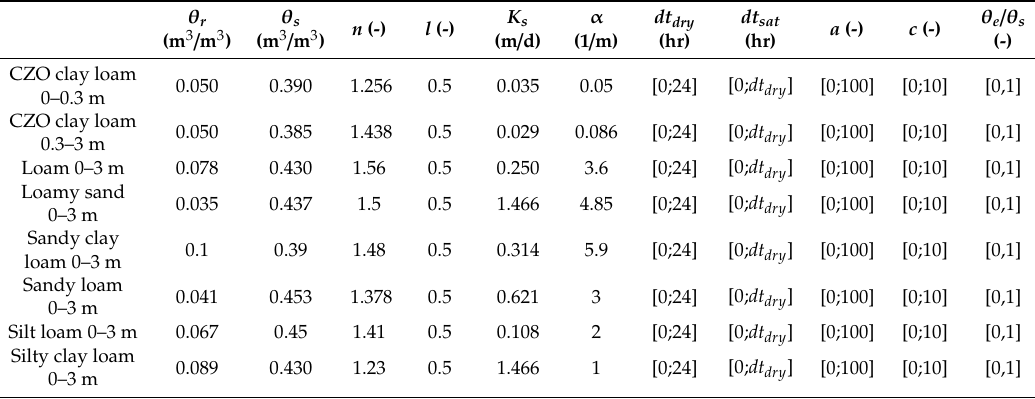
Table 1. Input soil parameter values and the range of the calibration parameters used in the Shallow Subsurface Modelling Framework (SSMF). The procedure to determine the value of the soil parameters is described in the Supplementary Material. For the CZO clay loam profile, the soil parameters θ r , θ s , n , l , K s and α reported in this table were obtained from the calibration of the Richards equation with HYDRUS on soil data from the Sunjia catchment. For the six generic soil texture profiles, they are the literature values provided in HYDRUS by the ROSETTA pedotransfer model [29]. For all soil profiles, dt dry , dt sat a , θ e and c are the SSMF parameters. The ranges that were used for the calibration of the SSMF are given in the